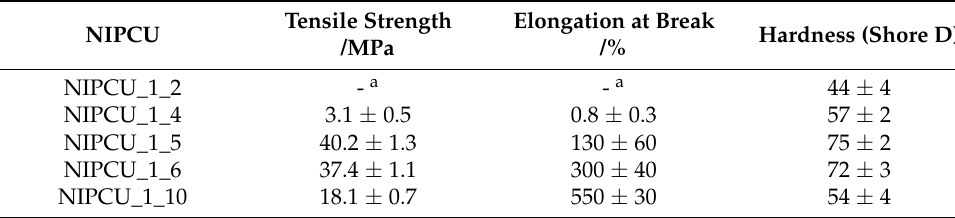
Figure 7. The strain–stress curves of NIPCUs differing in their structures of hard segments. Table 3. The mechanical properties of the obtained NIPCUs